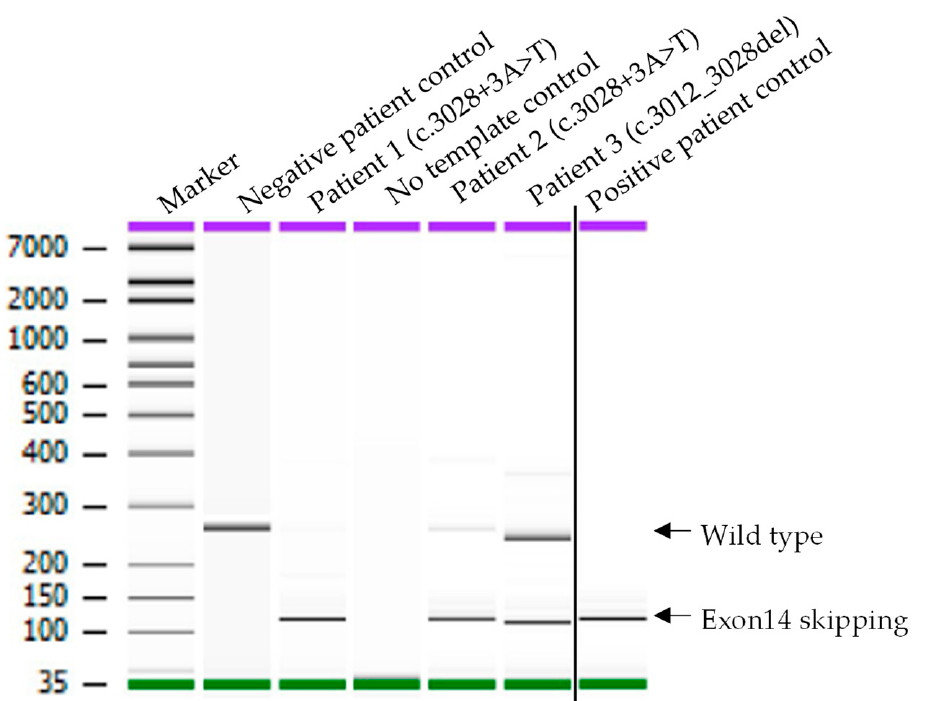
Figure 2. RT-PCR analysis on RNA from negative control and four patients with suspected (Patient 1 to 3) or known (positive control) METEx14 skipping variant, bronchial fine needle aspirate specimens. Gel picture from Bioanalyzer showing PCR products amplified using specific primers (MET_FP1 and MET_RP1). A fragment size of 260 indicates MET WT, and a fragment of 119 bp in size indicates MET exon 14 variant. No variant was identified in negative leukocytes.